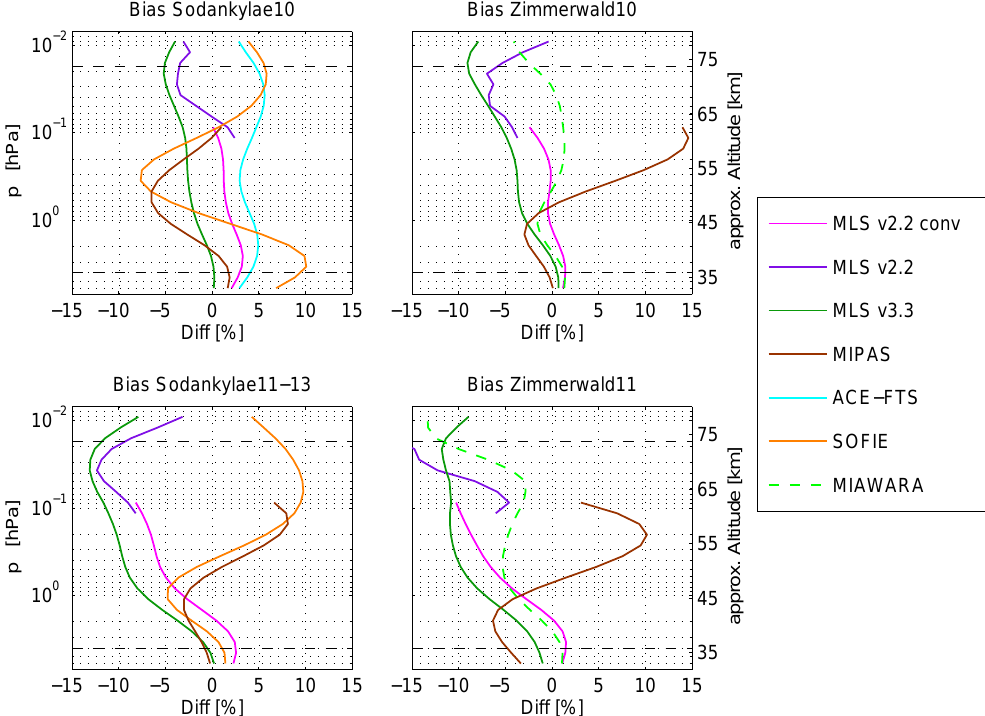
Fig. 15. Summary of all means of the differences relative to MIAWARA-C (bias) for both campaigns. All plots use MIAWARA-C data with AoA > 0.5. The dashed horizontal lines indicate the reliable altitude range (AoA >